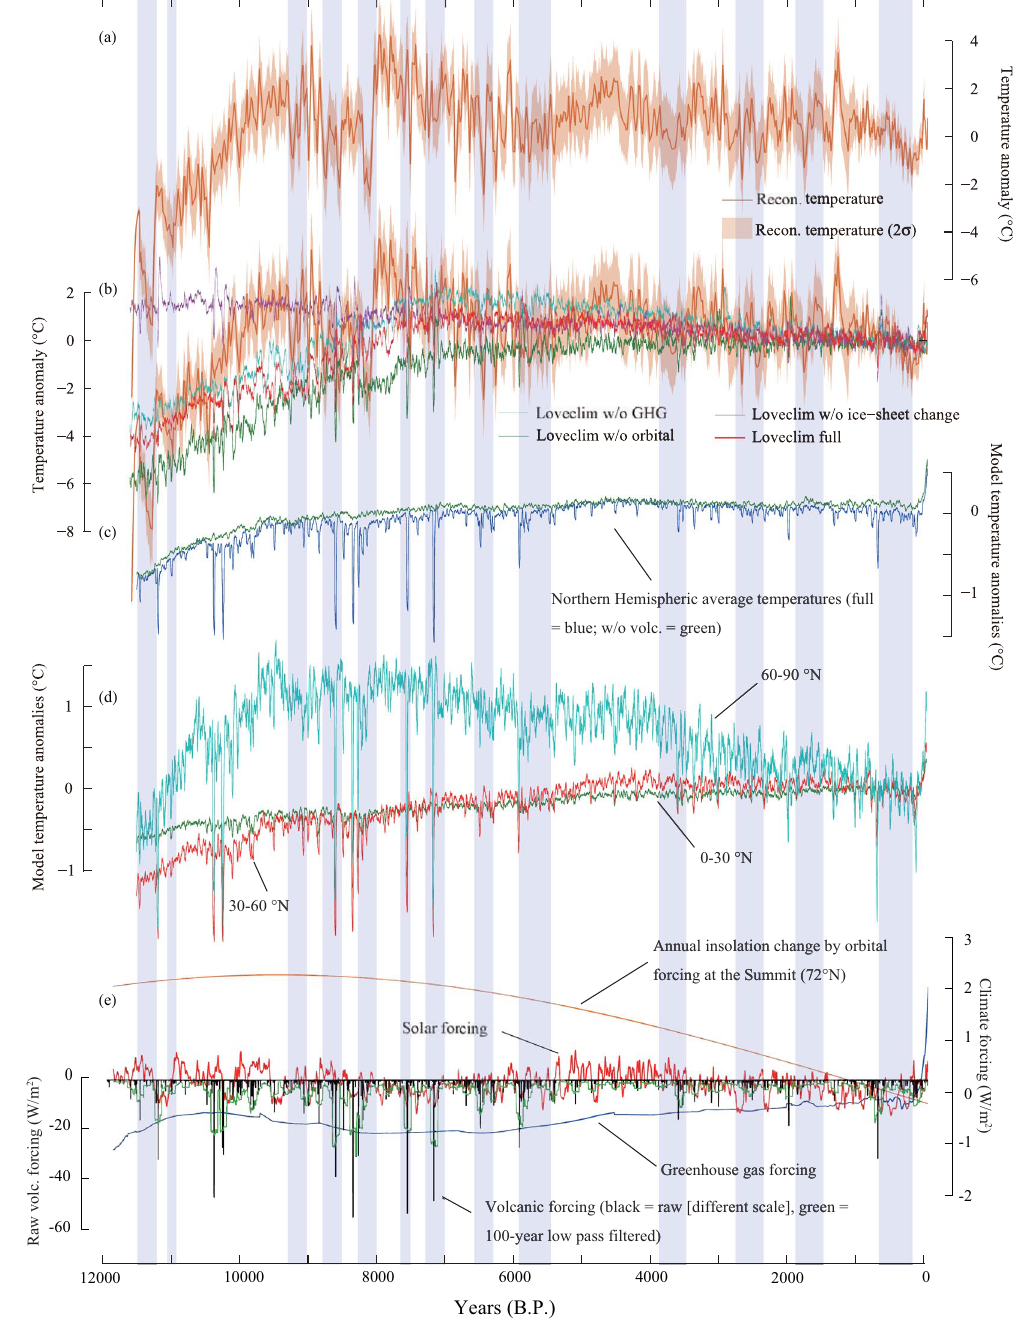
Figure 3. Holocene climate forcing. ( a ) Reconstructed Greenland temperature. ( b ) Reconstructed and modeled Greenland temperatures over the Holocene from various climate model experiments. Experiments without volcanic and solar forcing that exhibit long-term trends similar to that of full forcing are not shown for the sake of simplicity. ( c ) Modeled NH average temperatures with full forcing (blue) and without volcanic forcing (green) both relative to the average of the past 1000 years from the full forcing run. ( d ) Modeled high (60–90°N), middle (30–60°N), and low (0–30°N) latitude average temperatures. ( e ) Annual insolation at 72°N (orange) 63 and solar activity (red) 31 , GHG (blue; include CO 2 , CH 4 , and N 2 O, Methods) and volcanic forcing as raw (black) and 101-year RMs (green) (Methods). Note that the raw volcanic forcing has a different scale. Values are relative to averages of the past 1,000 years. Model outputs are from individual runs and smoothed by 21-year RMs. Blue shades are the Greenland cold episodes as in Fig.